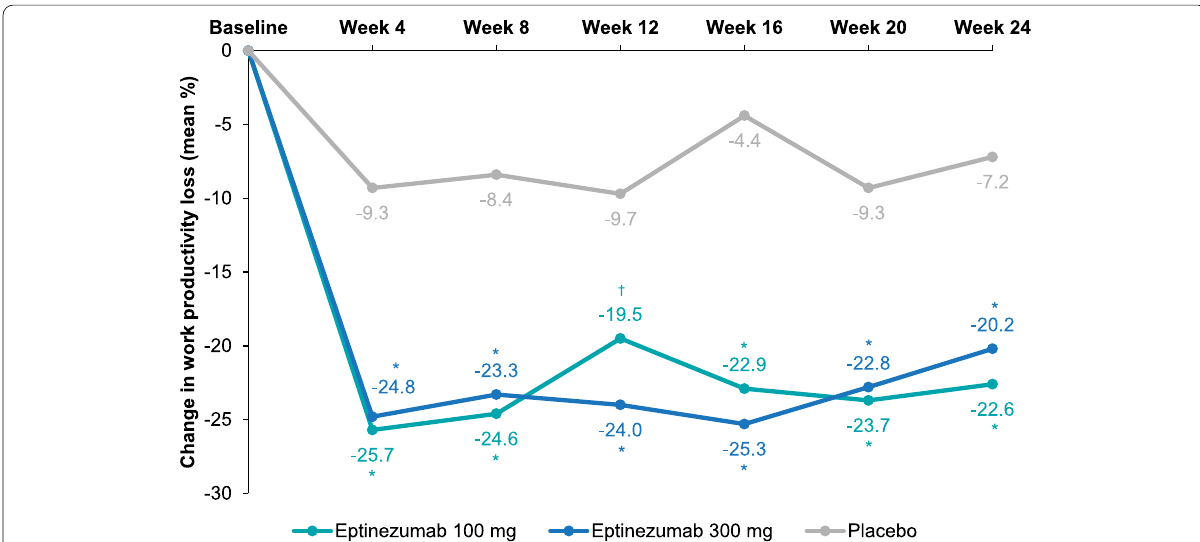
Fig. 3 Mean Changes From Baseline in WPAI:M Work Productivity Loss Subscores. Mean changes from baseline were calculated using LSMeans from a mixed model for repeated measures. The model included the following fixed effects: visit, country, stratification factor (monthly headache days at baseline: 14/> 14) and treatment as factors, baseline WPAI:M work productivity loss subscore as a continuous covariate, baseline ≤ score-by-visit interaction, treatment-by-visit interaction, and stratum by-visit interaction. * P < 0.0001 vs placebo; † P < 0.001 vs placebo. WPAI:M,